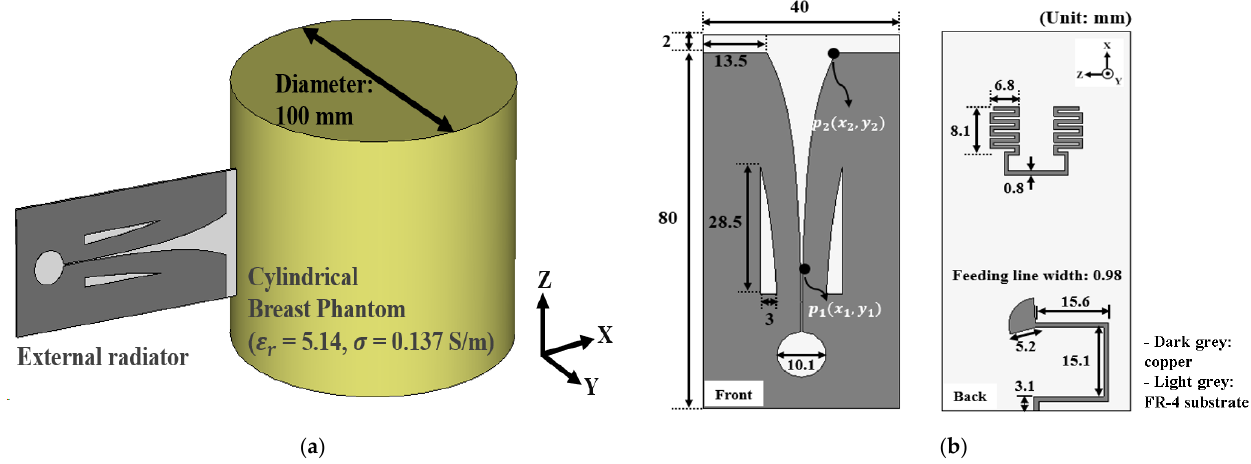
Figure 1. ( a ) Simulation configuration of the single tapered slot antenna (TSA) and ( b ) geometry of this antenna for microwave hyperthermia [25].